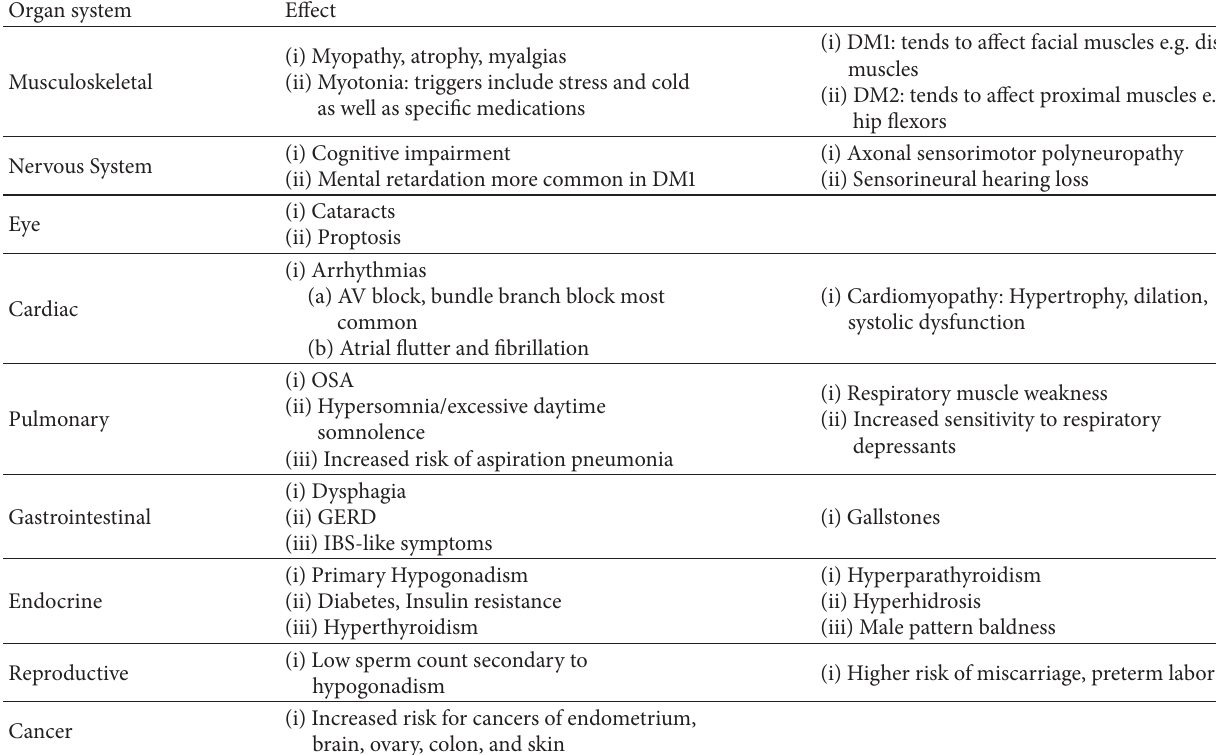
Table 1: Summary of DM effects on organ systems.